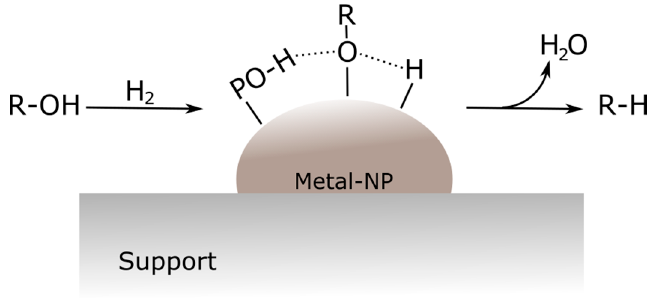
Figure 8. Proposed mechanism for HDO on a transition metal catalyst as described in Reference [66]; the graphics are redrawn according to the reference.